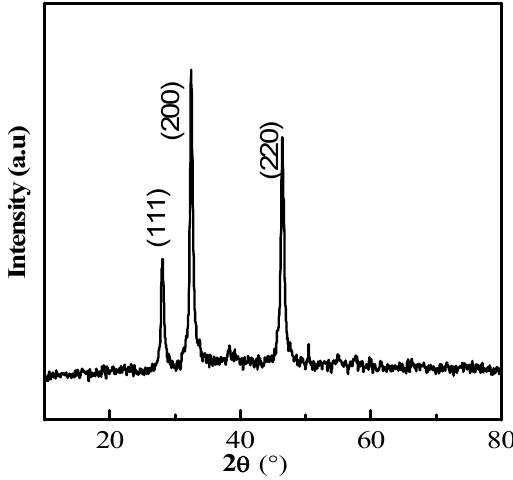
Figure 5. XRD profile of the silver nanoparticles derived from marine Streptomyces sp. Al-Dhabi-87.